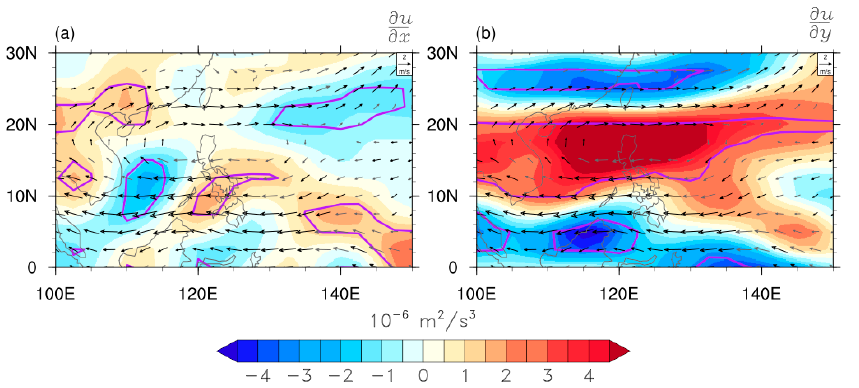
Figure 7. Difference of horizontal wind at 850 hPa between Pos_year and Neg_year: ( a , b ) show the difference in the zonal and meridional gradients of zonal wind; purple contours indicate p -level of 0.05; vectors show the difference in horizontal wind at 850 hPa.